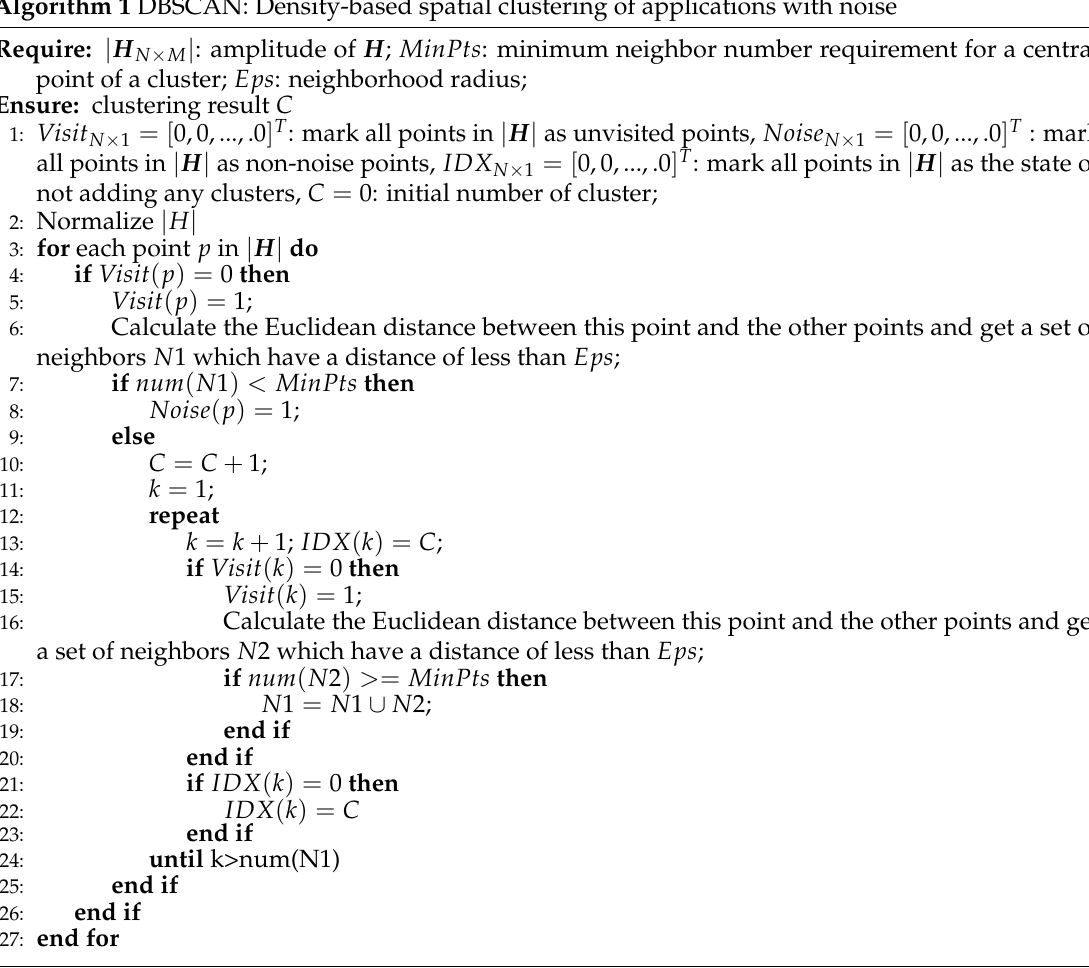
Figure 2. Different cluster numbers for the Channel State Information (CSI) amplitude can be observed at differant locations. ( a ) Amplitude of CSI at location a. ( b ) Amplitude of CSI at location b. Algorithm 1 DBSCAN: Density-based spatial clustering of applications with